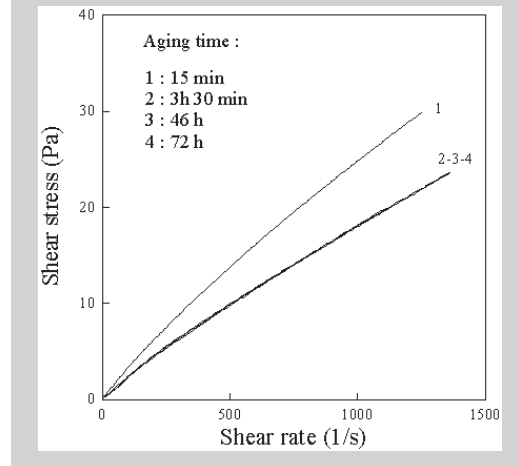
Figure 3 (left): Flow curves of E2emulsion (42 vol. %) for different aging times. Figure 4 (right): Variation of the yield stress with bentonite